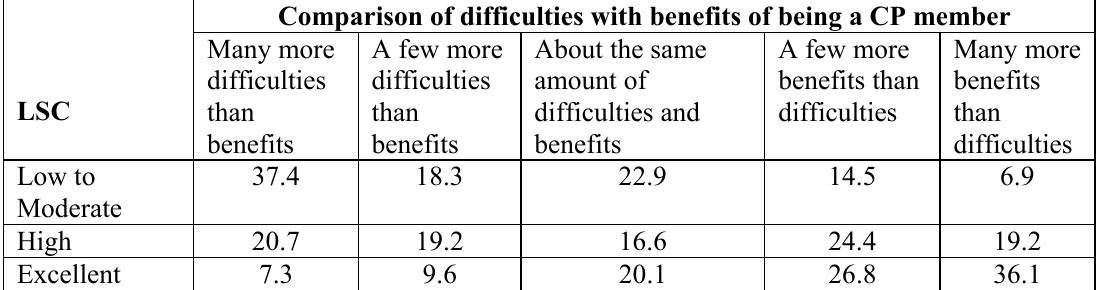
Table 4. Leadership Skills Score by participation costs to benefits